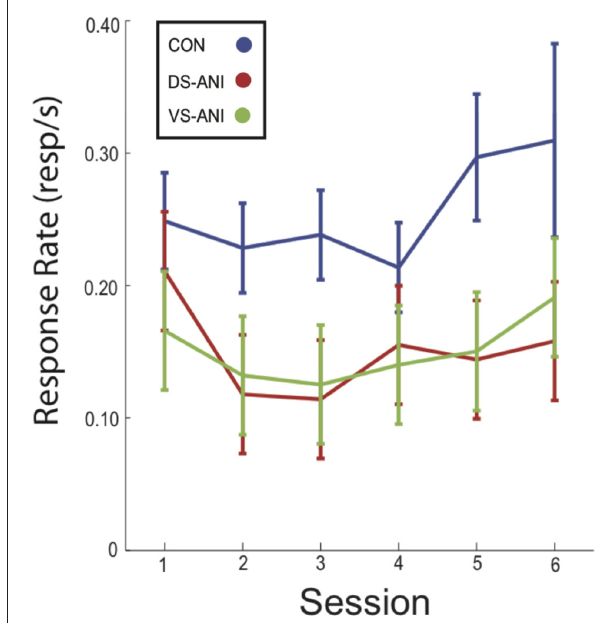
FIGURE 3 | Mean ( ± SEM) response rate (responses/s) during probe trials across each of the six ANI treatment sessions for CON (blue), DS-ANI (red), and VS-ANI (green) treatment groups in Experiment 1. ANI = anisomycin; CON = control; DS = dorsal